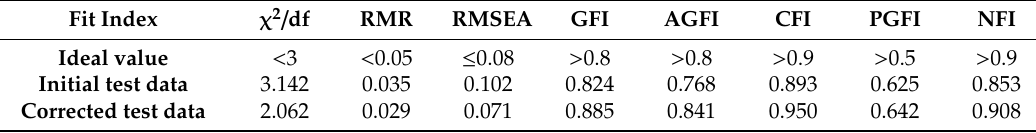
Table 4. Comparison of fitting degree between initial hypothesis model and modified